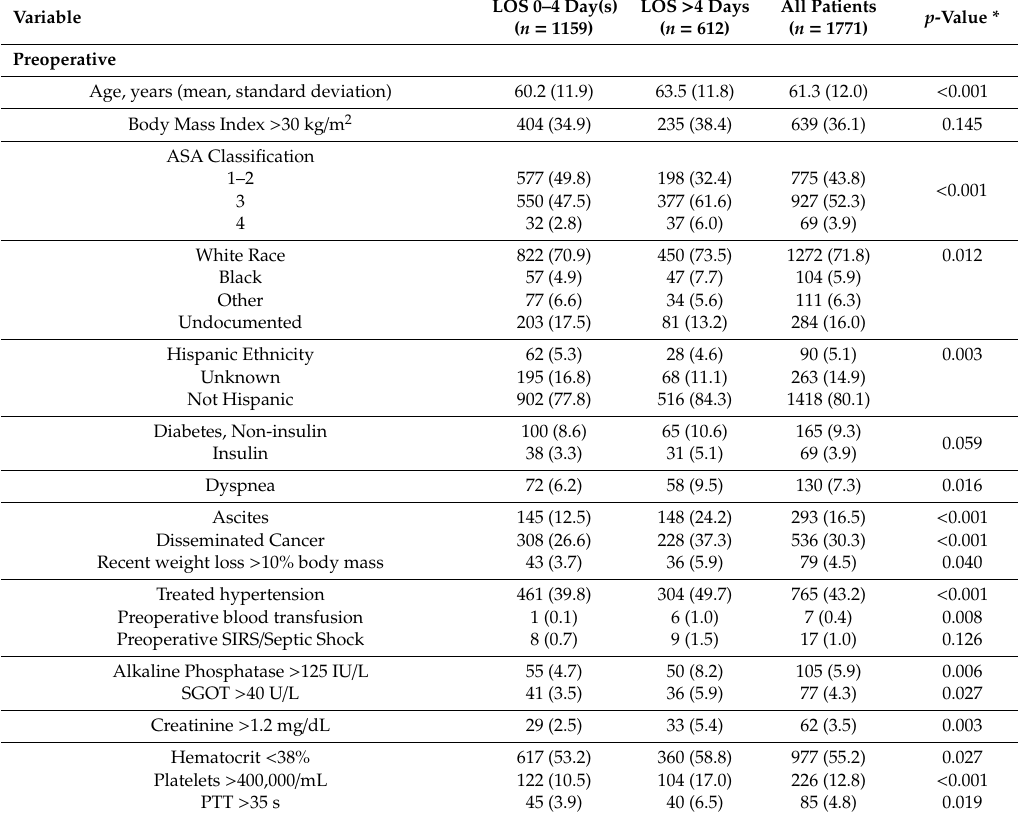
Table 1. Preoperative and intraoperative variables of patients undergoing surgery for ovarian cancer, stratified by length of stay. Median length of stay was 4